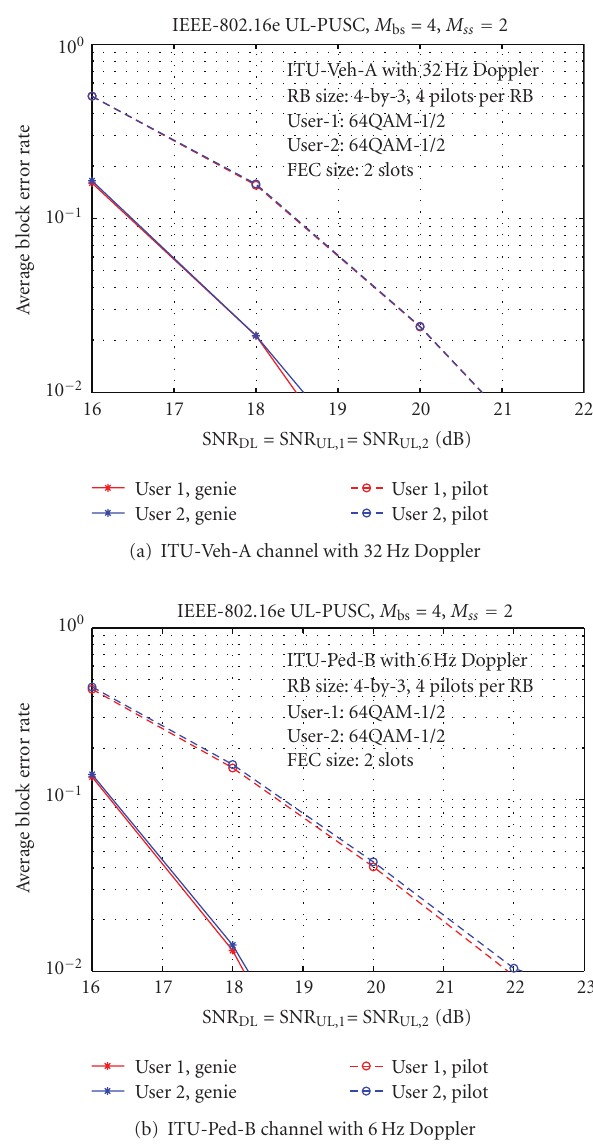
Figure 9: Performance of MMSE-BAF on MIMO-OFDMA-based IEEE 802.16e system using uplink partial utilization of sub- channelization (PUSC) permutation. Each user employs rate-1 / 2 convolutional turbo coding (CTC) with QPSK modulation. The FEC block length is 480 information bits which corresponds to 10 slots, with 48 modulation symbols per slot, as per the terminology in [13].